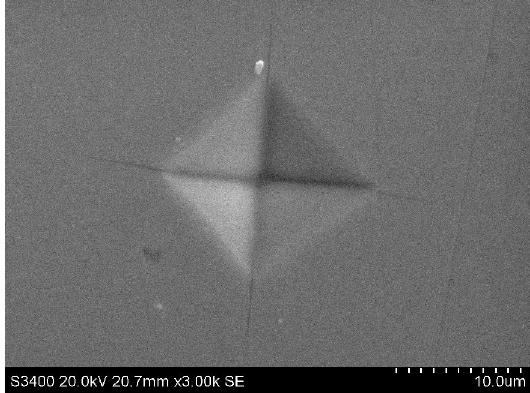
Figure 1. SEM image of sample EB 700 prepared at 2 GPa, 700 °C for 0.5 h. The image shows an indentation produced by a 105 g (1.03 N) load. Cracks emanating from the indentation corners are clearly visible in the Figure indicating brittle behavior. There is also slight bulging along the indentation